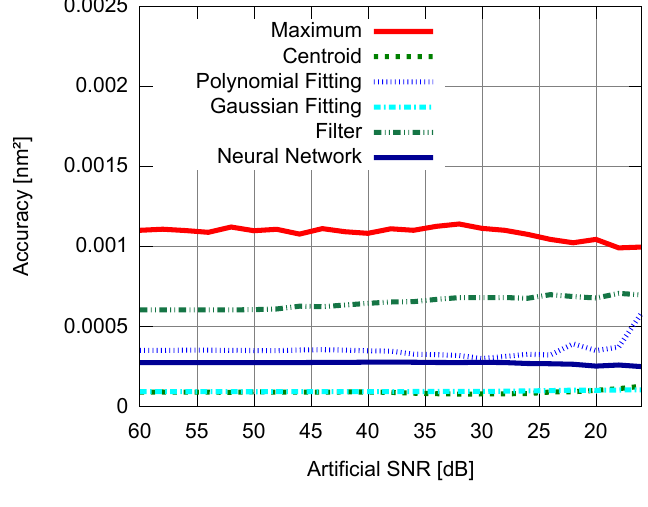
Figure 14. Accuracy for the experimental data test calculated using the mean square error between measured points and the fitted straight line.